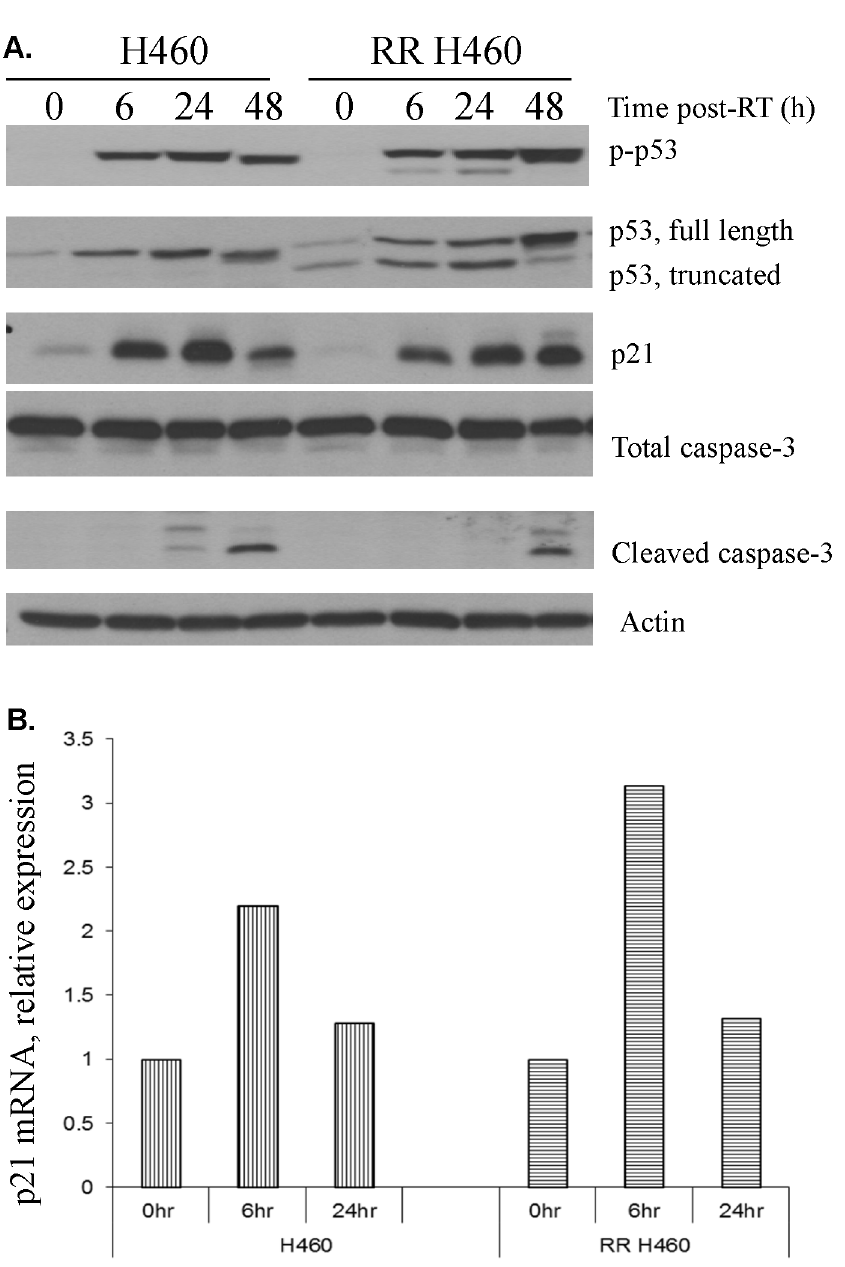
Figure 2. Characterization of parent and RR cell line after treatment with 6 Gy radiation. A. Subsequent protein expression was analyzed by Western blot. The parent and derivative cell lines were found to have comparable levels of total caspase 3. Expression of p53, phosphorylated p53, p21, and caspase cleavage were all delayed in the radiation resistant cell line. The radiation resistant cell line clearly shows two forms of p53, mutant and WT. B. mRNA analysis of p21 expression indicates that, in the hours immediately after irradiation, transcription is initially higher in the RR cell line, but by 24 h post-irradiation the levels are similar in the RR and parent cell lines.